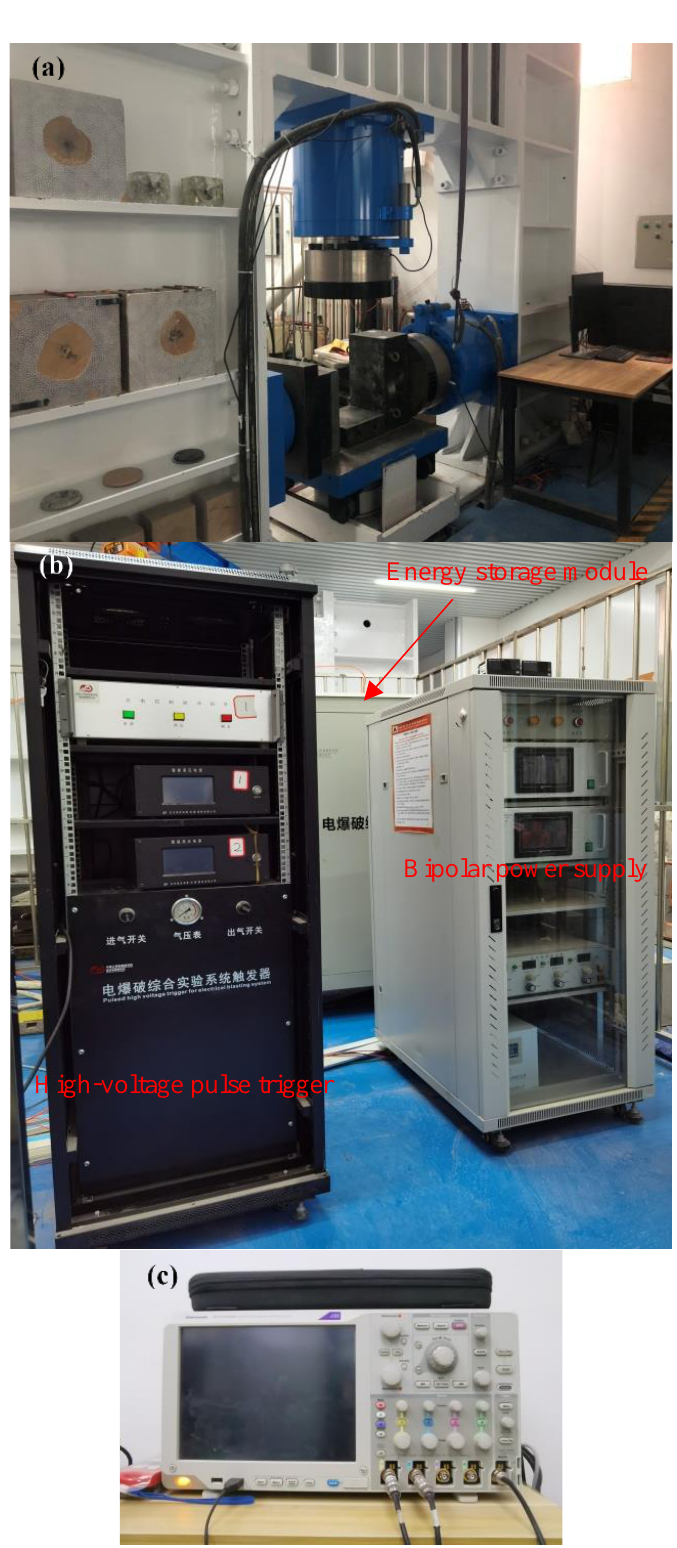
Figure 1. The experimental system: ( a ) The static pressure loading device; ( b ) The PHVD device; ( c ) The oscilloscope.